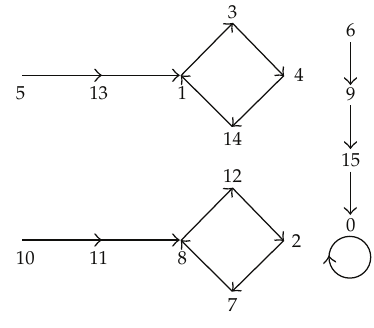
Figure 3: STD of (cid:4) 22 , 22 , 22 , 22 (cid:5) NB.